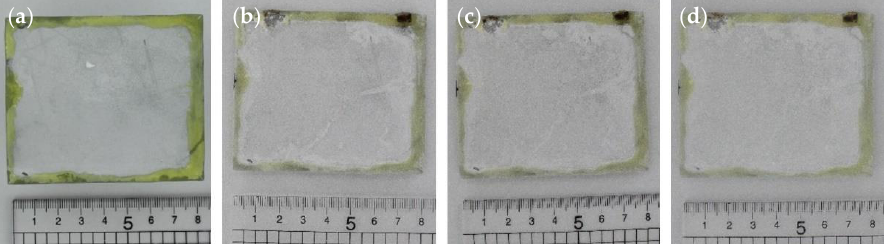
Figure 12. Humidity samples of coated HDG at ( a ) 0 h ( b ) 250 h ( c ) 500 h and ( d ) 1000 h.